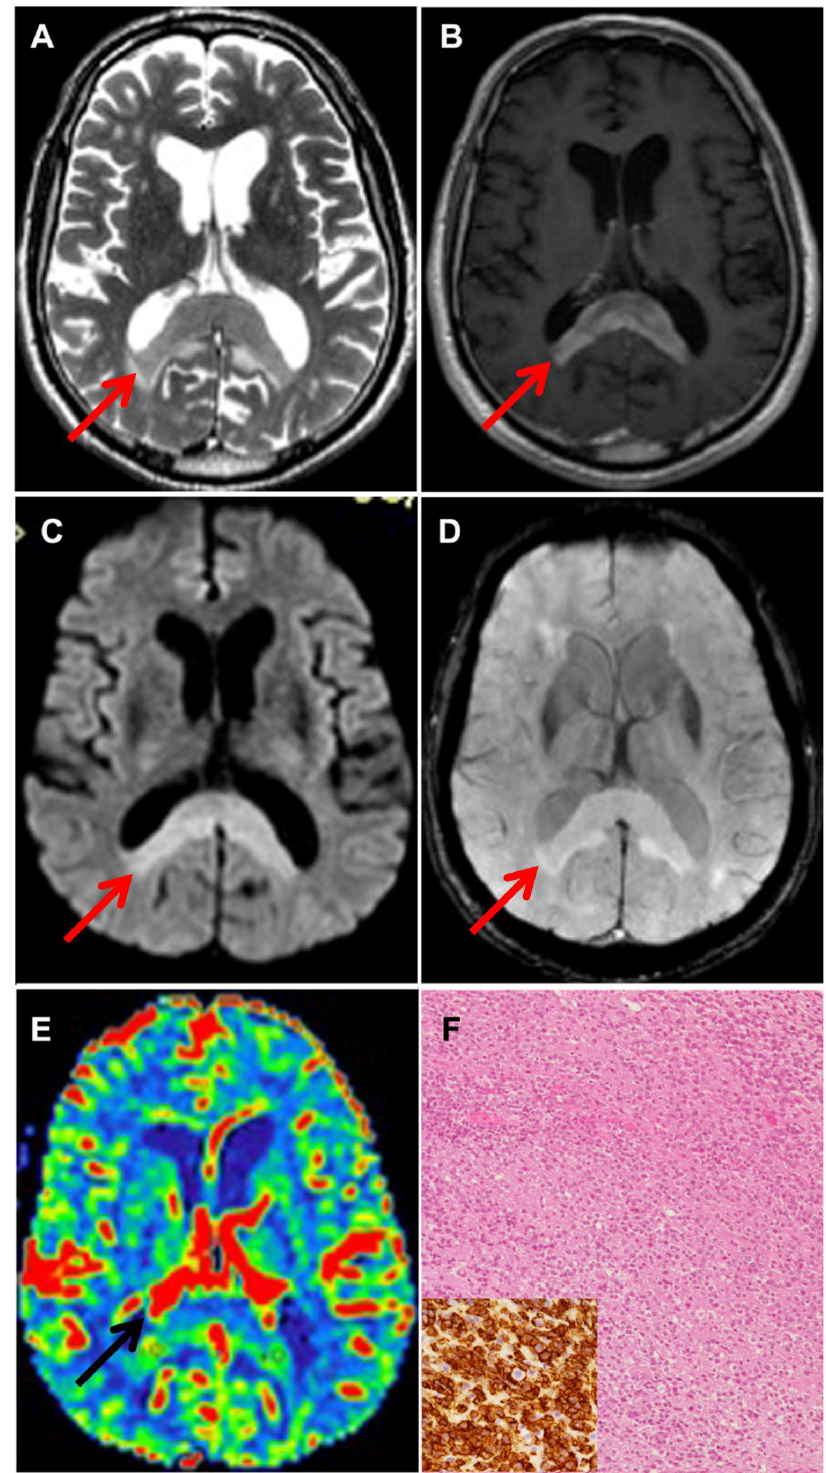
Figure 1. Neuroradiological and histological features of PCNSL. ( A ) Axial T2-weighted and ( B ) axial Gd-enhanced T1-weighted MR imaging showing a T2 hypointense mass involving splenium of the corpus callosum, without necrosis, and with vivid contrast enhancement. DWI ( C ) showing restricted diffusion and SWI ( D ) showing absence of intratumoral hemorrhage. Arrows point at the tumor ( A – E ). CBV map ( E ) shows moderately increased intratumoral rCBV. The neuropathological examination reveals a high-grade diffuse B cell non-Hodgkin lymphoma ( F ) showing strong CD20 positivity ( F , inset).